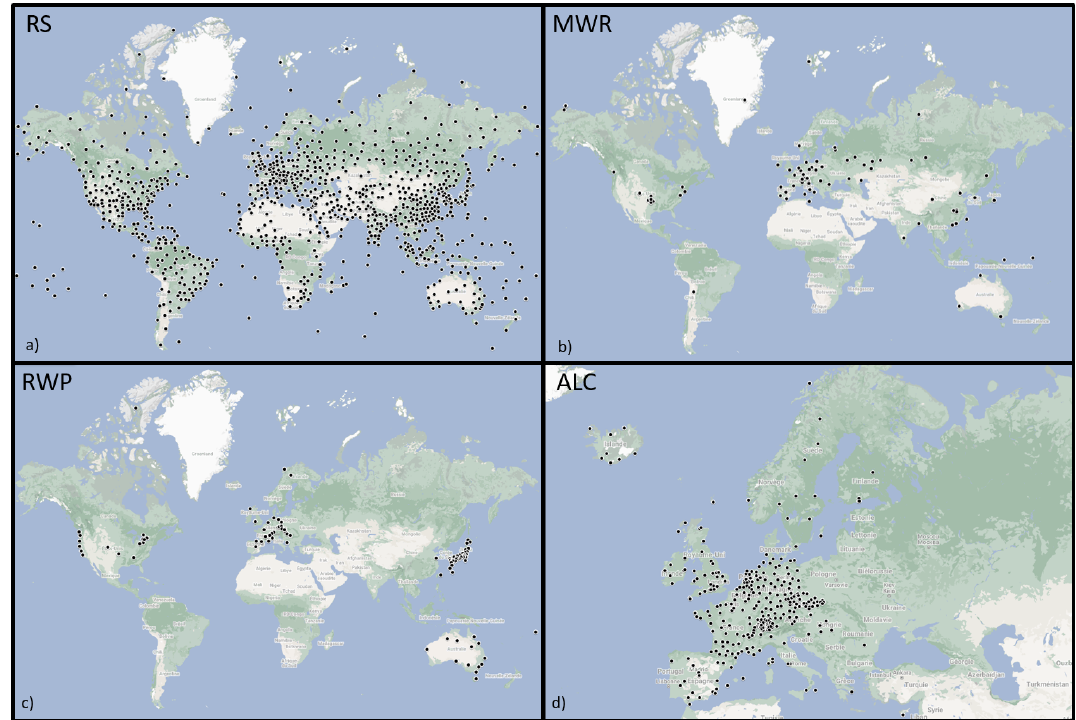
Figure 3. Selected operational networks of profiling stations (status December 2021): (a) global distribution of radiosonde stations